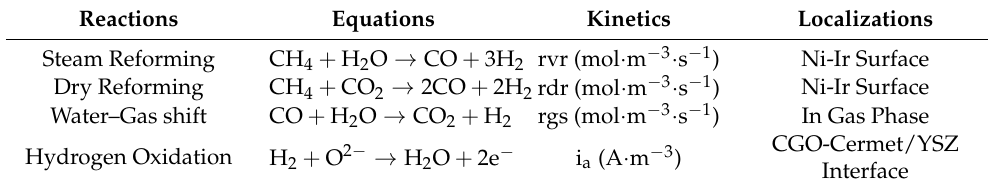
Table 3. Reactions considered in cell.